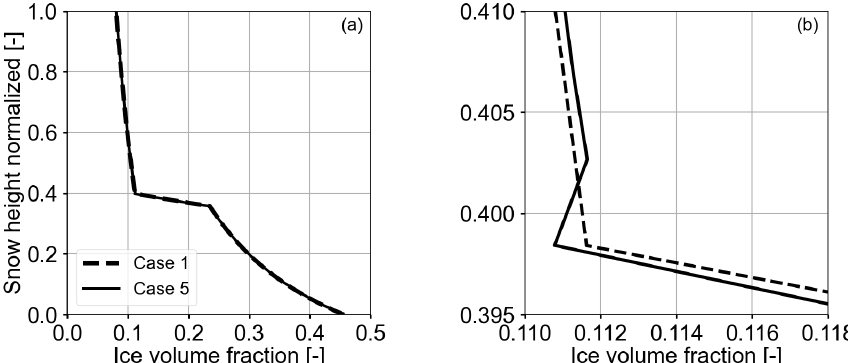
Figure 8. The plots show ice volume fraction profiles over the normalized snow height after 2d. (a) Case 1 (Table 2) depicts the ice volume fraction corresponding to solely active settling, and Case 5 refers to the fully coupled processes. Panel (b) zooms in to the density transition area of (a) . The kink in the profile of Case 5 shows the effect of the increased sublimation in Fig. 7 that yields a local decrease in the ice volume fraction. In order to better resolve the kink of Case 5, we increased the number of grid nodes to 251.